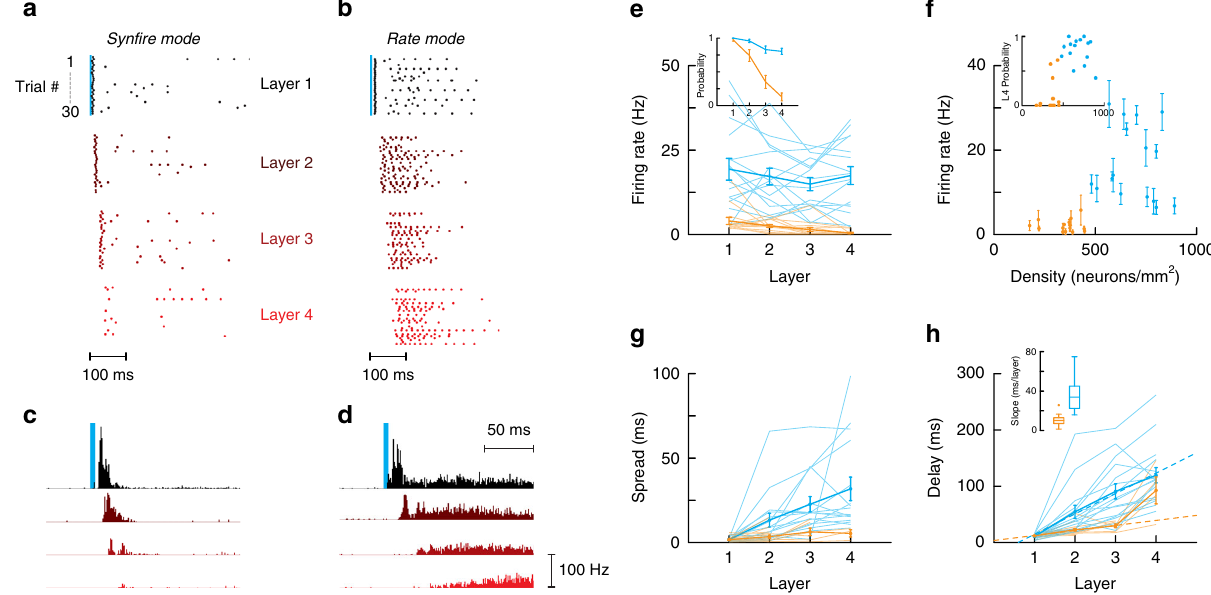
Fig. 2 Activity propagation in multilayer networks in culture. a, b Examples of dot rasters showing spikes recorded in cell-attached mode from individual neurons in each layer. Synchronized light stimuli were delivered to ChR2-expressing (non-recorded) neurons in the fi rst layer (30 repetitions of the light stimuli). Data in a , b are, respectively, from sparse and dense networks. c , d Average poststimulus time histogram (PSTH) of action potentials in each layer from sparse ( c ) and dense ( d ) networks. A single neuron was recorded in each layer (from black to red for layers 1 – 4, respectively). e Firing rate measured in a 300 ms time window after the stimulus. Inset, probability of evoking at least one spike vs layer in sparse (orange) and dense (blue) networks. f Firing rate averaged over all layers vs network density. Inset: spike probability in the 4th layer as a function of density. g , h Temporal spread ( g ) and delay ( h ) of fi rst spike vs recorded layer in sparse (orange) and dense (blue) networks. In h dashed lines represent a linear fi t to the data with slopes of 8.9 ms per layer and 36.2 ms per layer for sparse and dense networks respectively. The statistical signi fi cance between the two distributions of slopes for individual networks was assessed using Mann – Whitney U -test ( P = 1.7 × 10 − 6 ). In e – h all data are shown and the mean ± SEM is represented as thick lines. Data for PSTH in c , d and plots in e – h are compiled from n = 15 sparse (347 ± 81 neurons·mm − 2 ) and n = 16 dense (686 ± 122 neurons·mm − 2 )